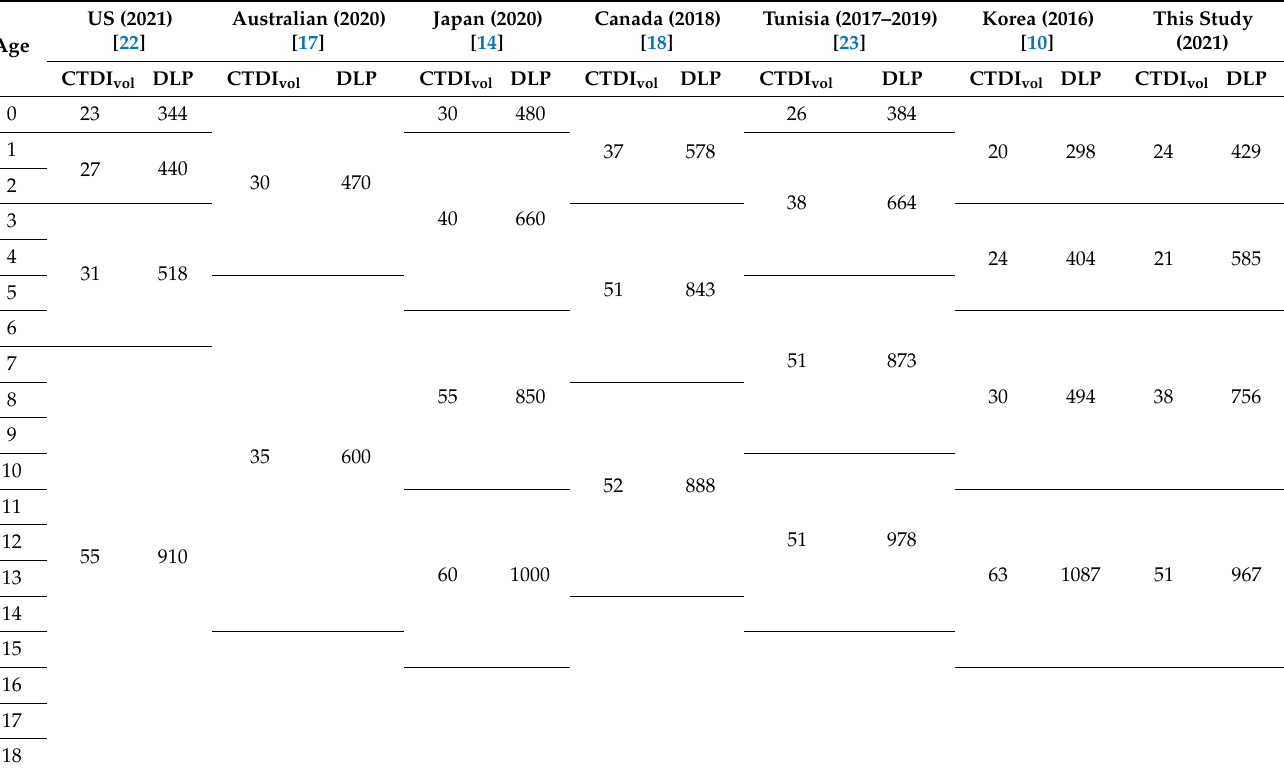
Table 7. Comparison of 75th % DRLs between other countries and the current survey of pediatric brain CT protocols.